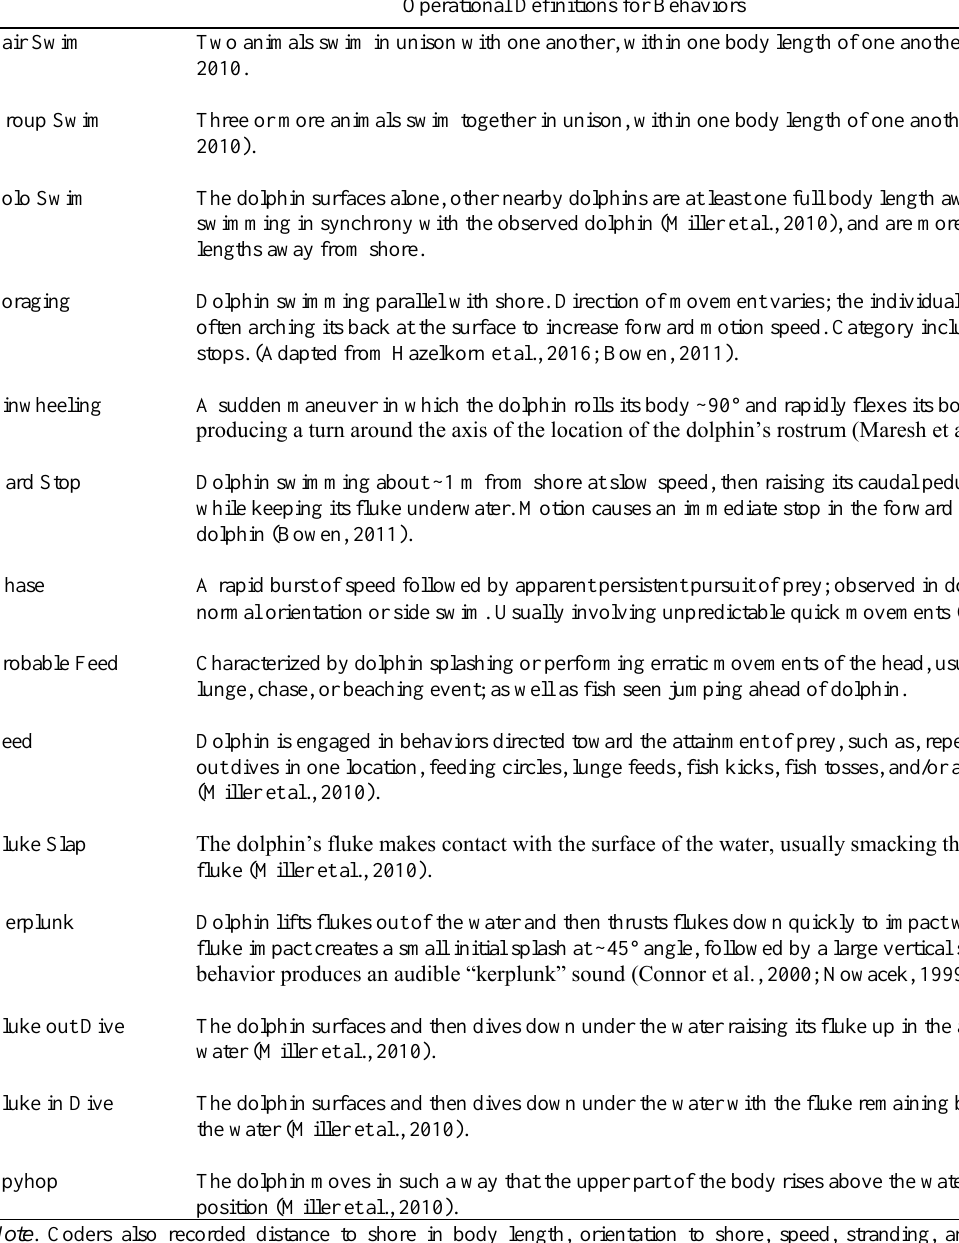
Operational Definitions Used for Video Coding of Behaviors